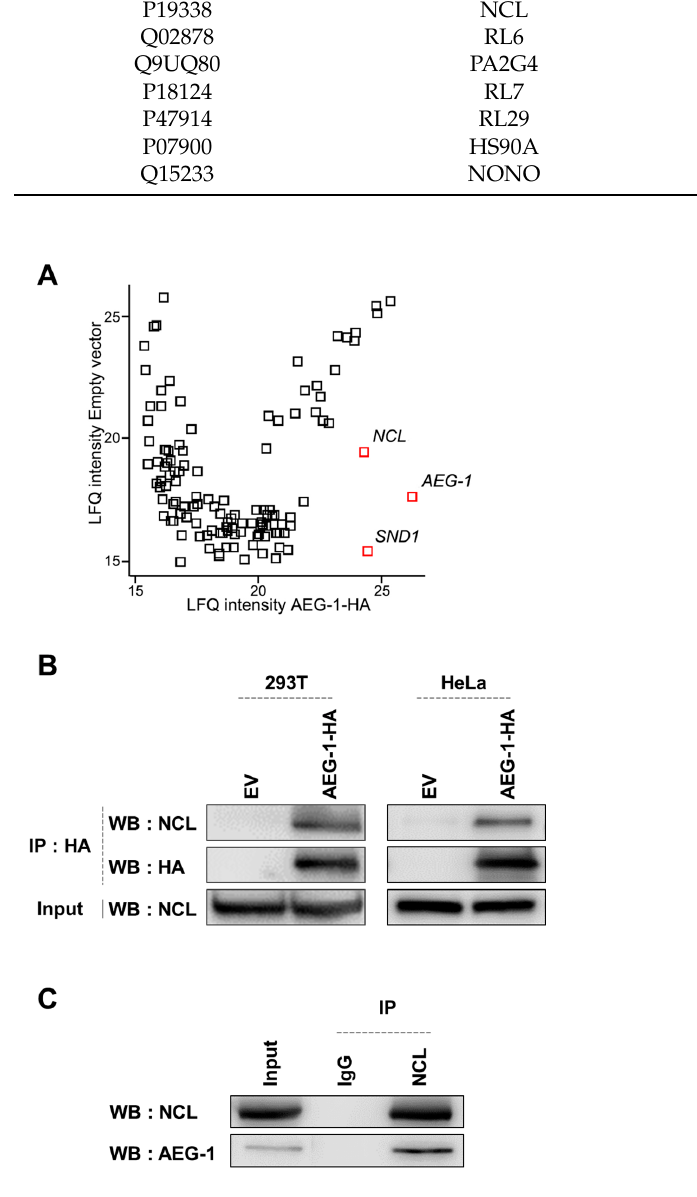
Figure 1. Identification of NCL as a novel AEG-1-interacting protein. ( A ) The scatter plot shows label free quantification (LFQ) values of proteins identified from AEG-1-HA (X-axis) or empty vector (Y-axis) transfected samples. Perseus software (ver. 1.6.14.0) was employed for visualization. ( B ) 293T and HeLa cells were transfected with either an empty vector (EV) or the AEG-1-HA expression vector. Immunoprecipitation (IP) was performed using anti-HA antibodies; co-immunoprecipitated NCL was analyzed by western blot. ( C ) Endogenous NCL was immunoprecipitated in 293T cells and co-immunoprecipitated AEG-1 was analyzed by western blot. Table 1. List of AEG-1 interacting proteins revealed by LC-MS/MS analysis.